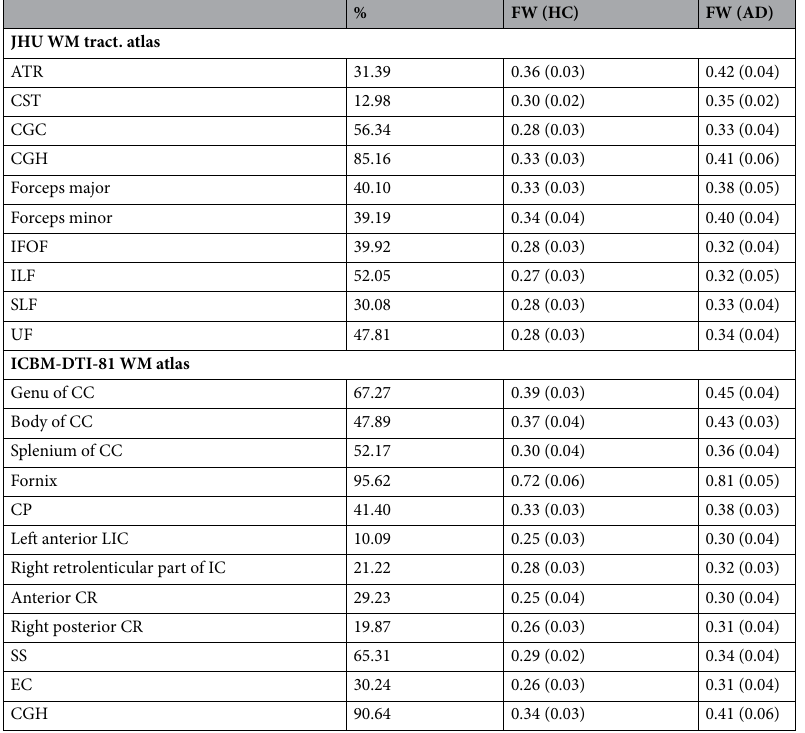
Table 3. Brain locations where clusters of significant differences between groups were found for FW maps analysis at p < 0.01 (FWE corrected). % columns indicate the percent volume of the cluster inside the corresponding brain area. Only clusters with higher FW values in AD than HC were observed. For JHU white- matter tractography atlas: ATR anterior thalamic radiation, CST cortical spinal tract, CGC cingulum (cingulate